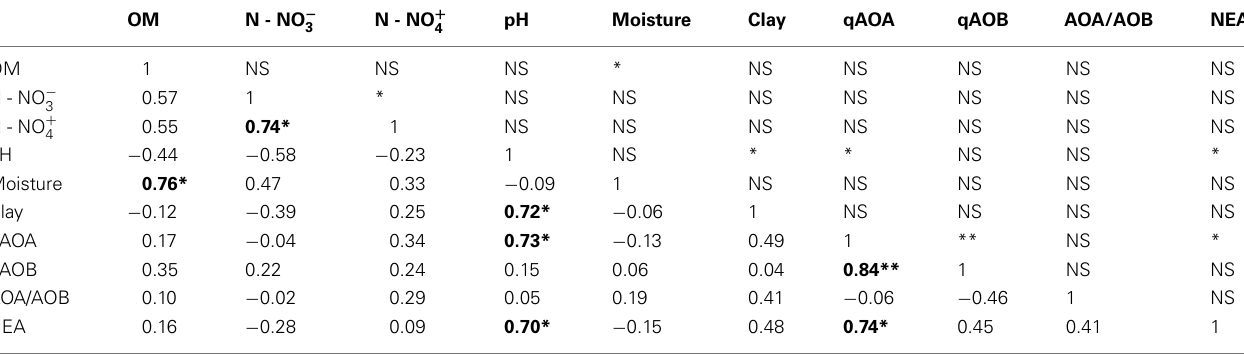
Table 2 | Pearson’s correlations ( r ) between community size (qAOA, qAOB, andAOA/AOB), nitrifying activity (NEA), and soil properties (OM, N - NO − , N - NH + , pH, moisture and clay), calculated as average values per soil between September 2009 and October 2010. 4 3